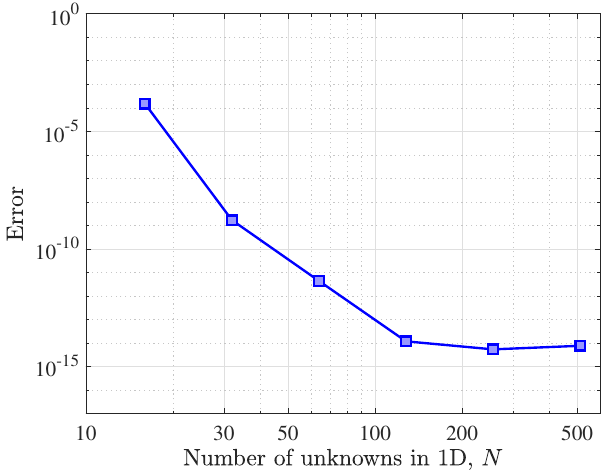
Figure 5. Error of numerical solutions of a 2-D Poisson equation with no exact solution. The numerical solutions here are obtained from the quasi-inverse matrix diagonalization method. The values of the errors are computed by comparing the numerical solution at each N with the one at N =